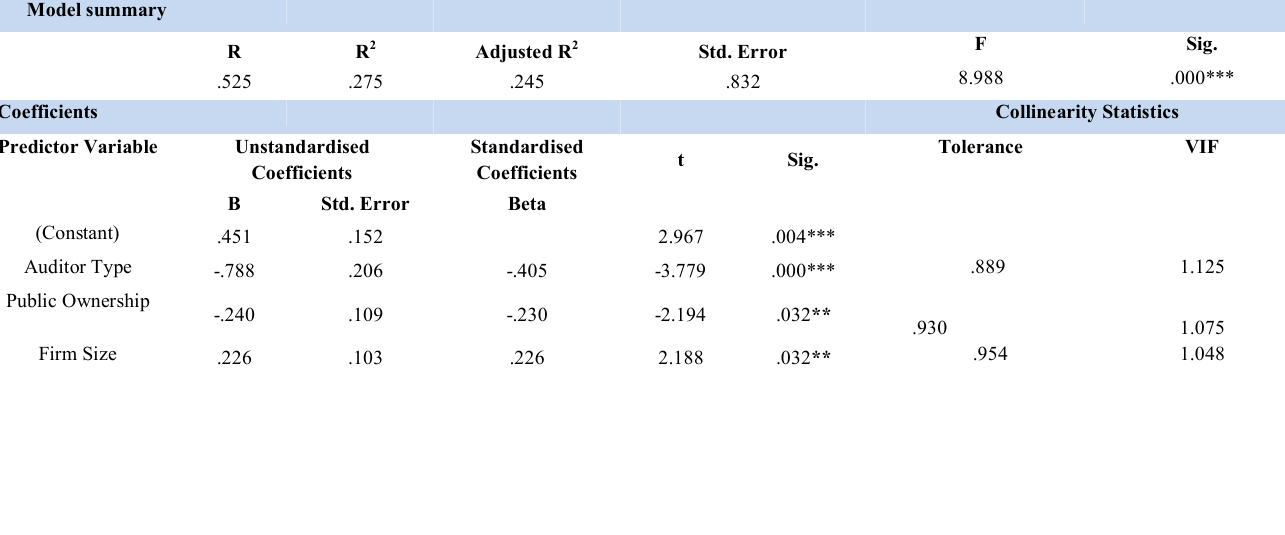
Table 3: Regression Results -